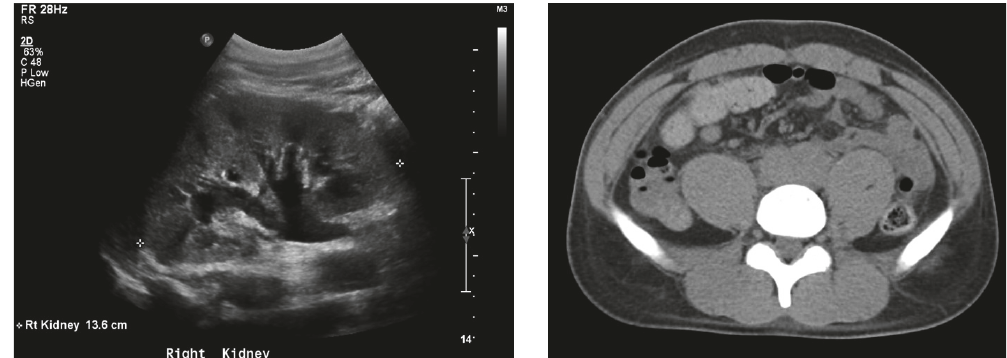
Figure 1: Initial imaging studies. Left: renal ultrasound at presentation revealed moderately enlarged kidneys with increased renal cortical echogenicity and mild bilateral hydronephrosis. Right: abdomen and pelvis computed tomogram without contrast revealed mild inflammatory changes without lymphadenopathy.